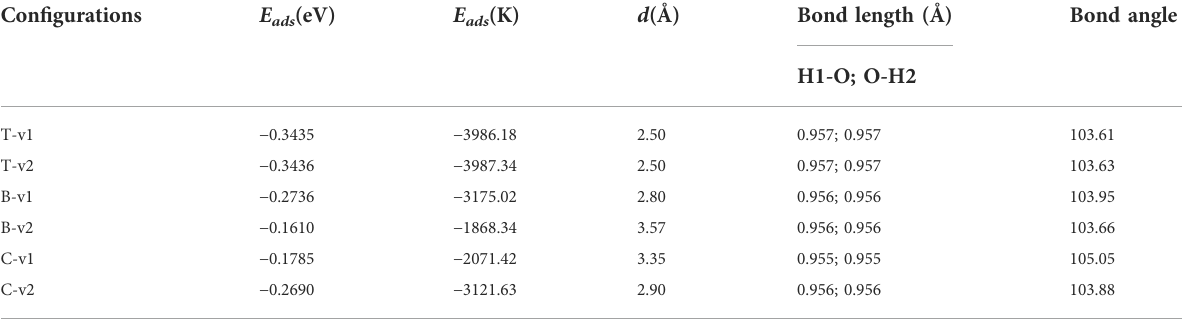
TABLE 1 H 2 O on the graphene-like surface: E ads , d and the bond length and bond angle of H 2 O. Con fi gurations